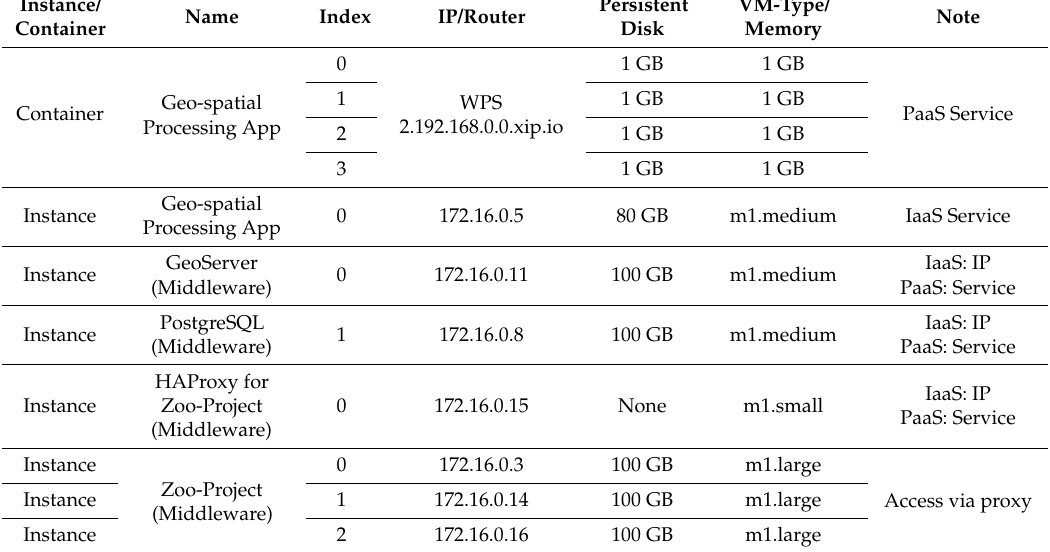
Table 3. Open source solutions and middleware types for the geo-spatial image processing service system of IaaS and